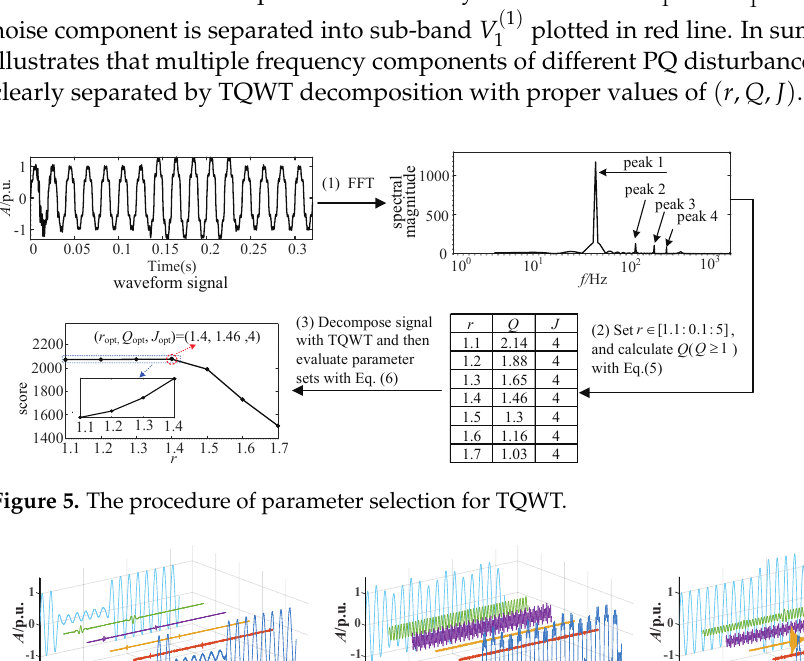
plotted in red line. In summary, Figure 6